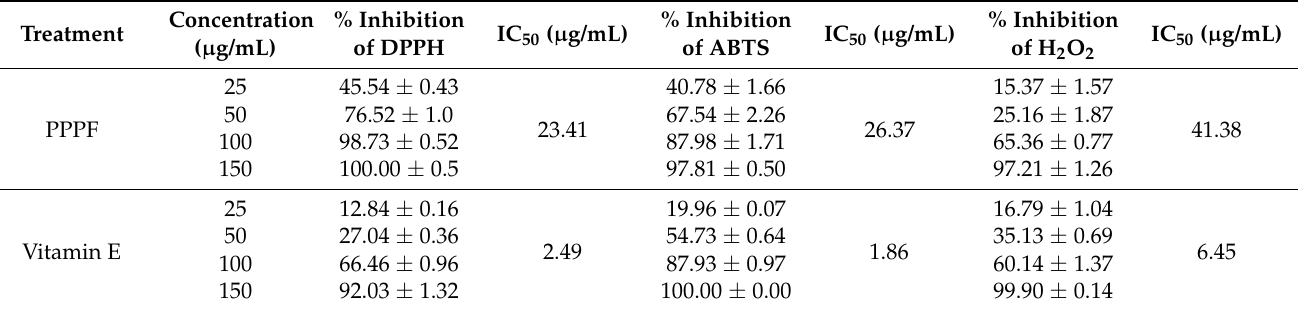
Table 3. Antioxidant activities of prickly pear peel flour (PPPF) extract and vitamin E as a standard against DPPH, ABTS and H 2 O 2